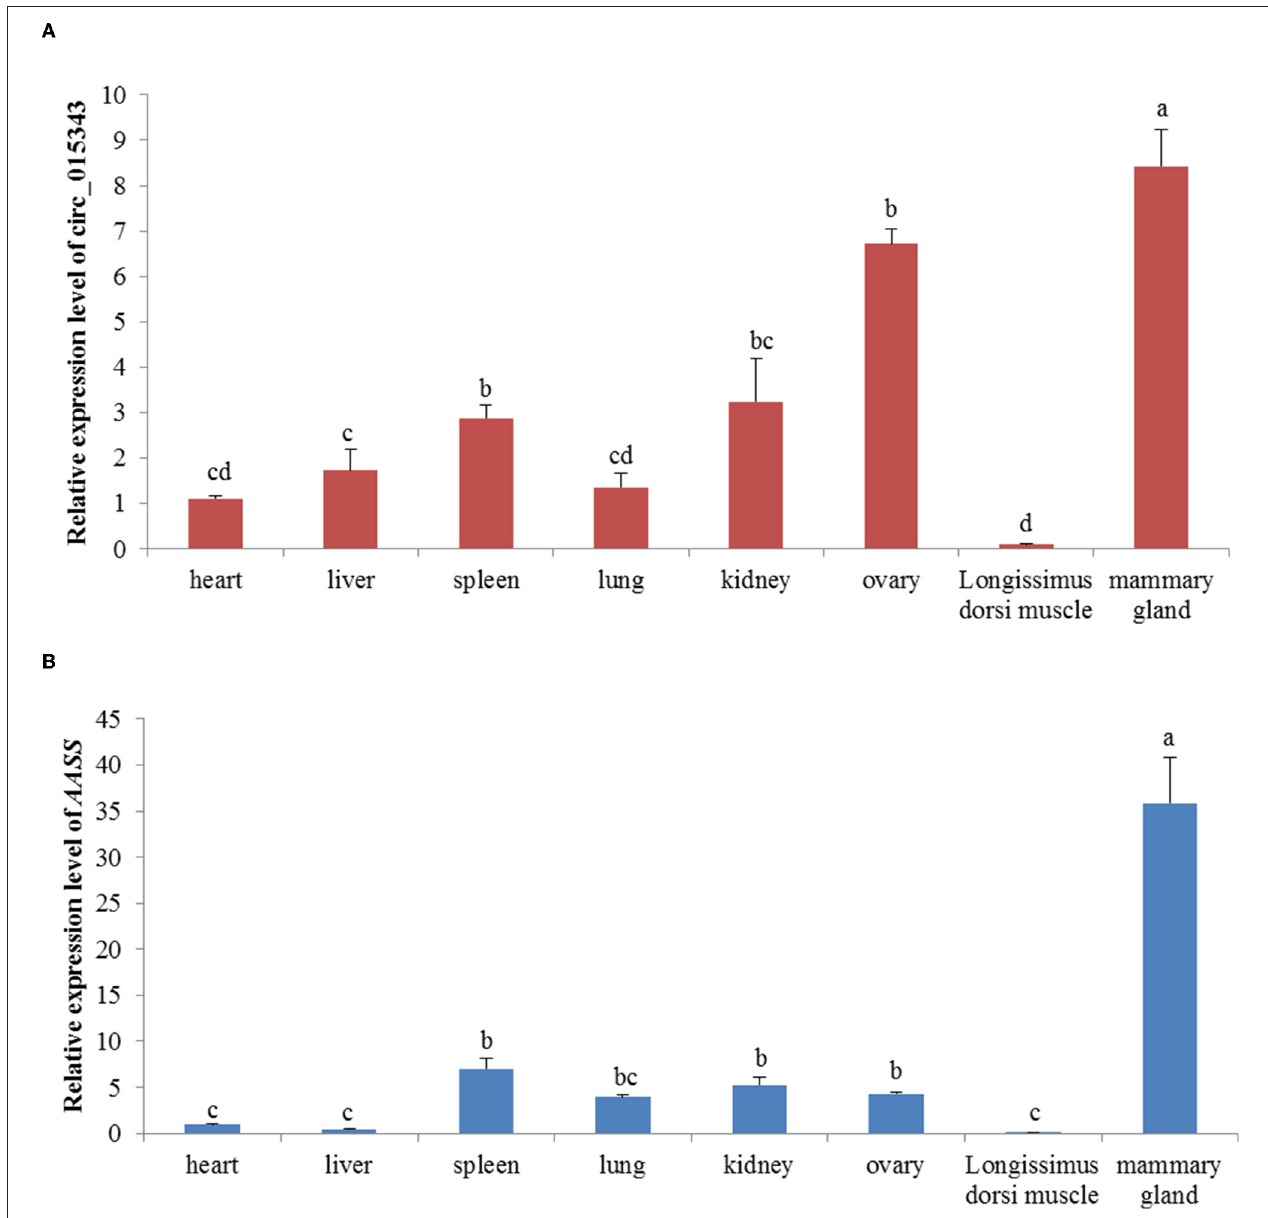
FIGURE 3 | Relative expression of circ_015343 (A) and AASS (B) in ovine eight different tissues. Different lowercase letters above the bars represent significant differences ( p < 0.05) between